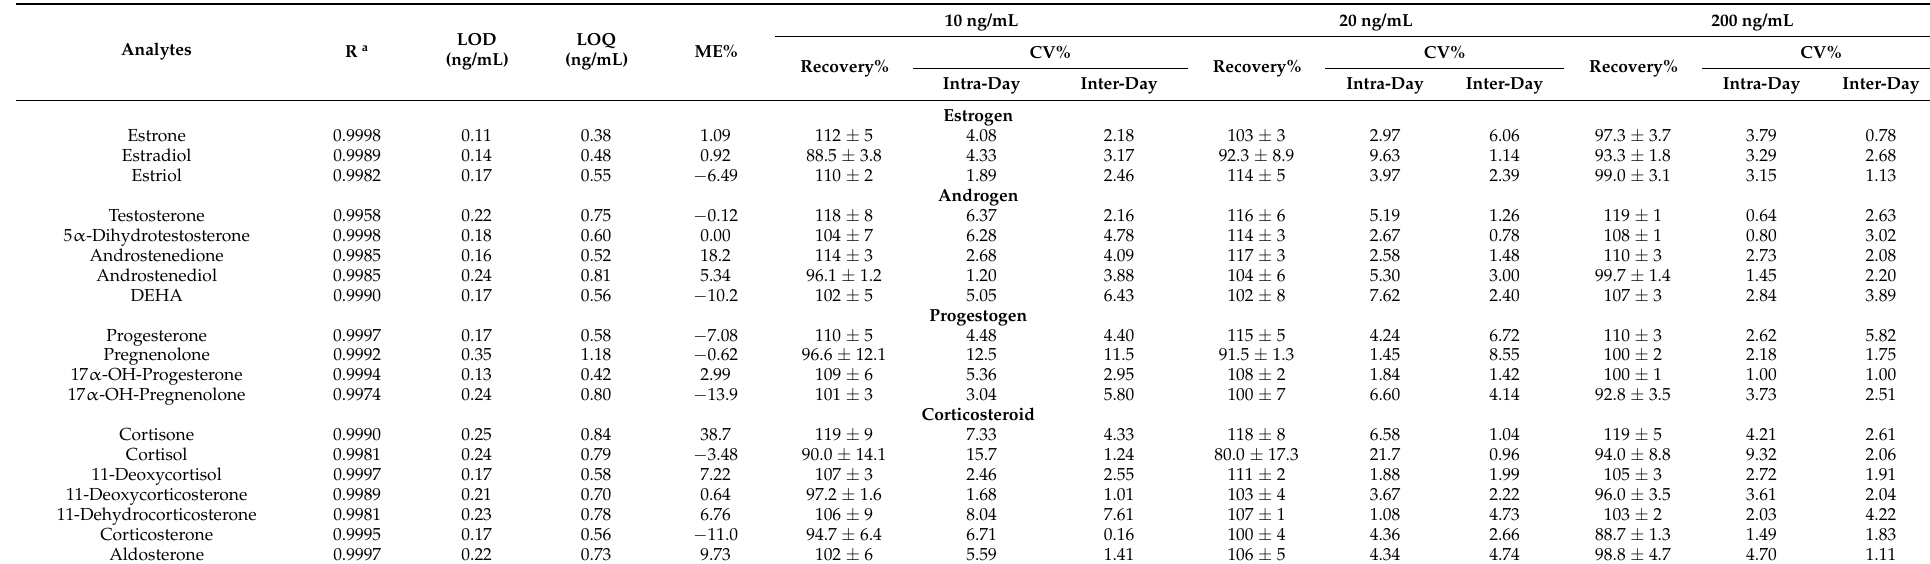
Table 3. Method validation parameters for the analysis of 19 steroid hormones in human